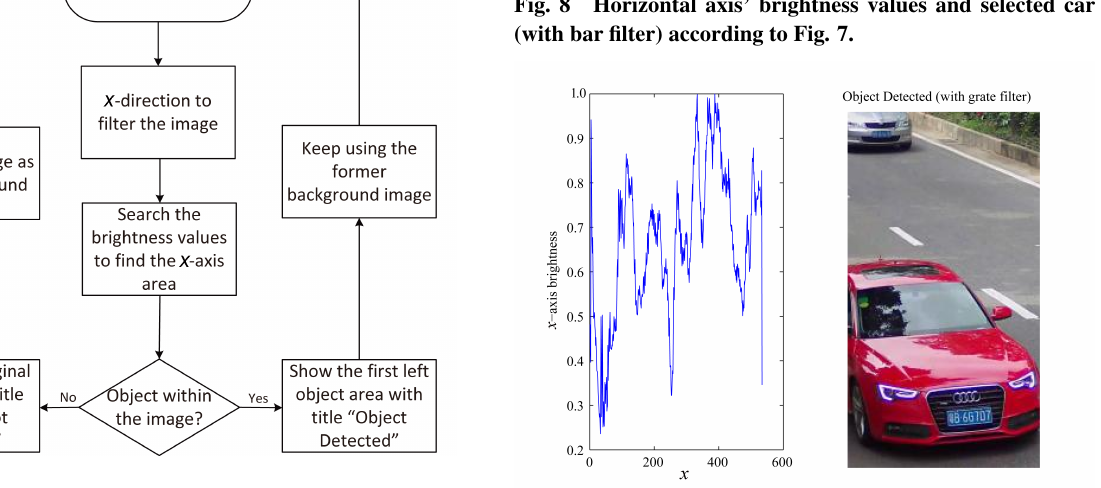
Fig. 9 Horizontal axis’ brightness values and selected car (with grate filter) according to Fig.